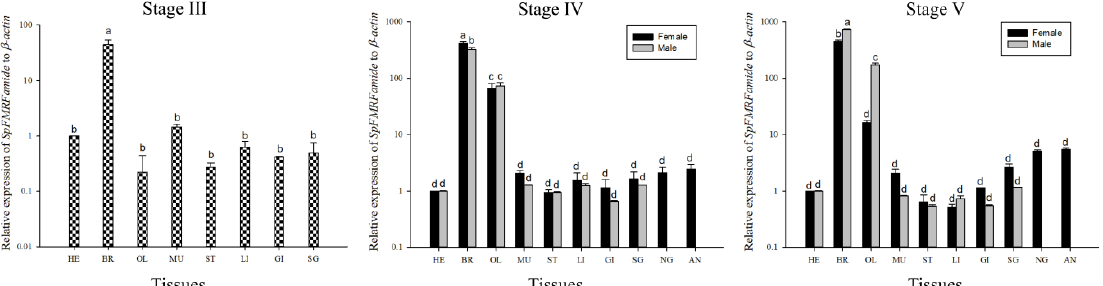
Figure 4. Expression analysis of SpFMRFamide from various tissues in three di ff erent stages (III, IV, and V). In each case, the expression level of the heart was regarded as the reference value. Vertical bars represented the mean ± standard deviation (SD) ( n = 3). The analyses were conducted in eight / ten di ff erent tissues including the heart (HE), brain (BR), optic lobe (OL), muscle (MU), stomach (ST), liver (LI), gill (GI), sexual gland (SG, including testis and ovary), nidamental gland (NG), and accessory nidamental gland (AN). β -actin served as a reference gene and a, b, c, and d on the bars represent statistically significant di ff erences among the tissues in the Least Significant Di ff erence (LSD) multiple comparison test of the Statistical Product and Service Solutions (SPSS) ( p < 0.05).